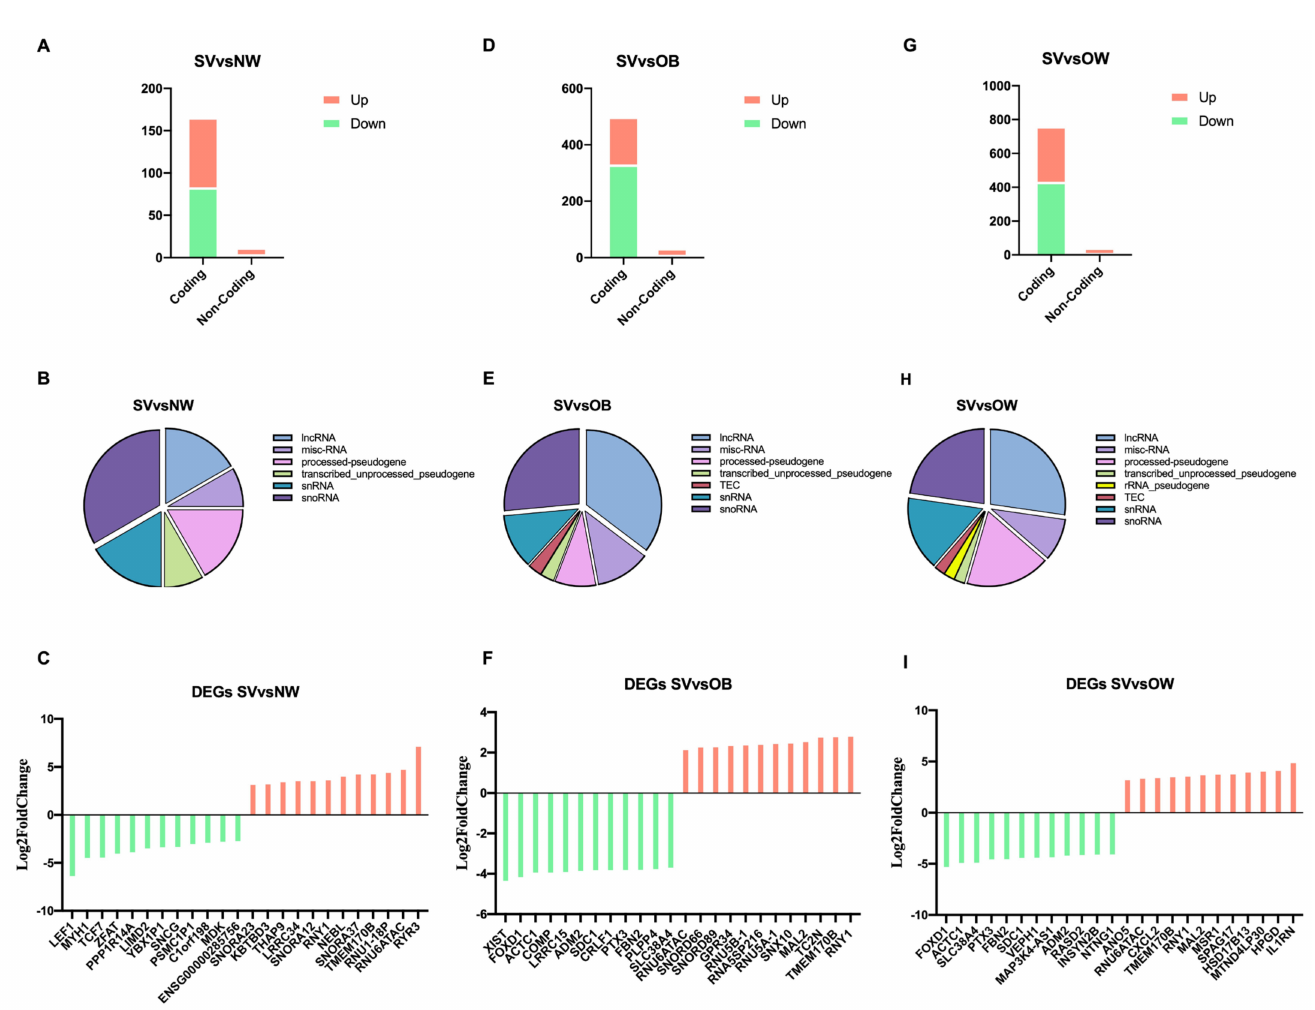
Figure 2. Analysis of RNA biotypes. ( A , D , G ): bar charts indicating downregulated and upregulated coding and non-coding DEGs found in the SV vs. NW, SV vs. OB, and SV vs. OW comparisons; ( B , E , H ): pie charts representing the subtypes of non-coding protein DEGs; ( C , F , I ): bar charts repre- senting the 12 most downregulated and upregulated genes. Green bars represent downregulated DEGs; red bars represent upregulated